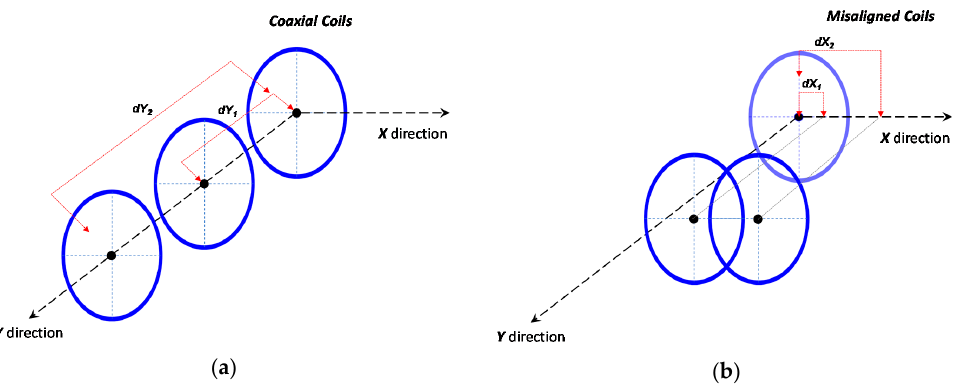
Figure 10. Cell displacement test, coaxial ( a ) and misaligned ( b ) configurations.